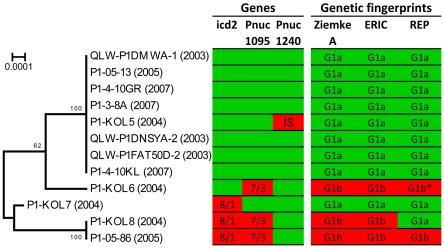
Microdiversity of the F10 lineage population of Pond-1.The genetic diversity of the twelve F10 lineage strains isolated from Pond-1 over a period of four years (2003–2007) is illustrated. Left panel. NJ tree based on concatenated nucleotide sequences of twelve loci (Table S4) with a total length of 9031 alignment positions. Middle panel. Only three out of 13 sequenced loci showed sequence polymorphism. The icd2 and Pnuc_1095 genes were present with two alleles differing in the sequenced parts in total in eight and seven positions (polymorphic positions), respectively. Numbers depict the total numbers of polymorphic sites (first number) and the number of non-synonymous sites (second number) among the polymorphic sites. The locus Pnuc_1240 of strain P1-Kol5 differed from all other sequenced strains in the presence of an insertion element (IS, insertion sequence). Sequences of Pnuc_1240 were not considered in the calculation of the presented phylogenetic tree. Right panel.
Results from genetic fingerprinting with the independent methods RAPD (Ziemke A), ERIC, and REP-PCR. Each method resulted in different fingerprints, but each method revealed basically only two types of fingerprints (G1a and G1b). The REP-PCR fingerprint G1b* differed only weakly from G1b. Colors green and red indicate that the respective strains share or do not share, respectively, a particular trait with the genome-sequenced strain QLW-P1DMWA-1.